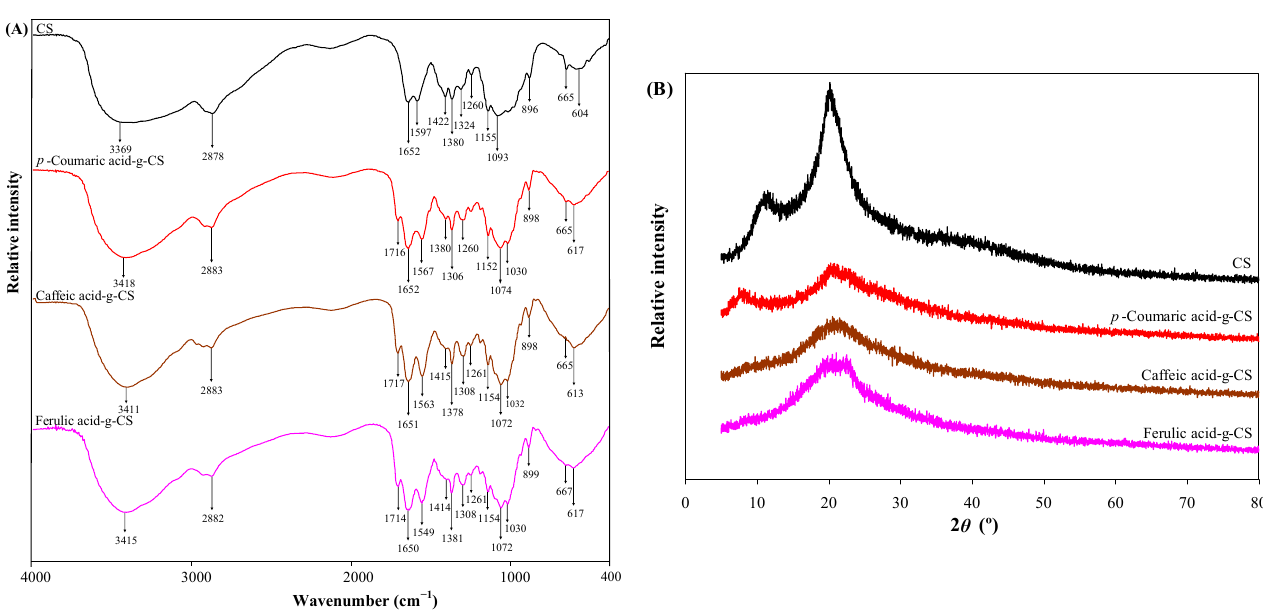
Figure 2. FT-IR spectra ( A ) and XRD patterns ( B ) of chitosan (CS) and different hydroxycinnamic acid-g-CSs.